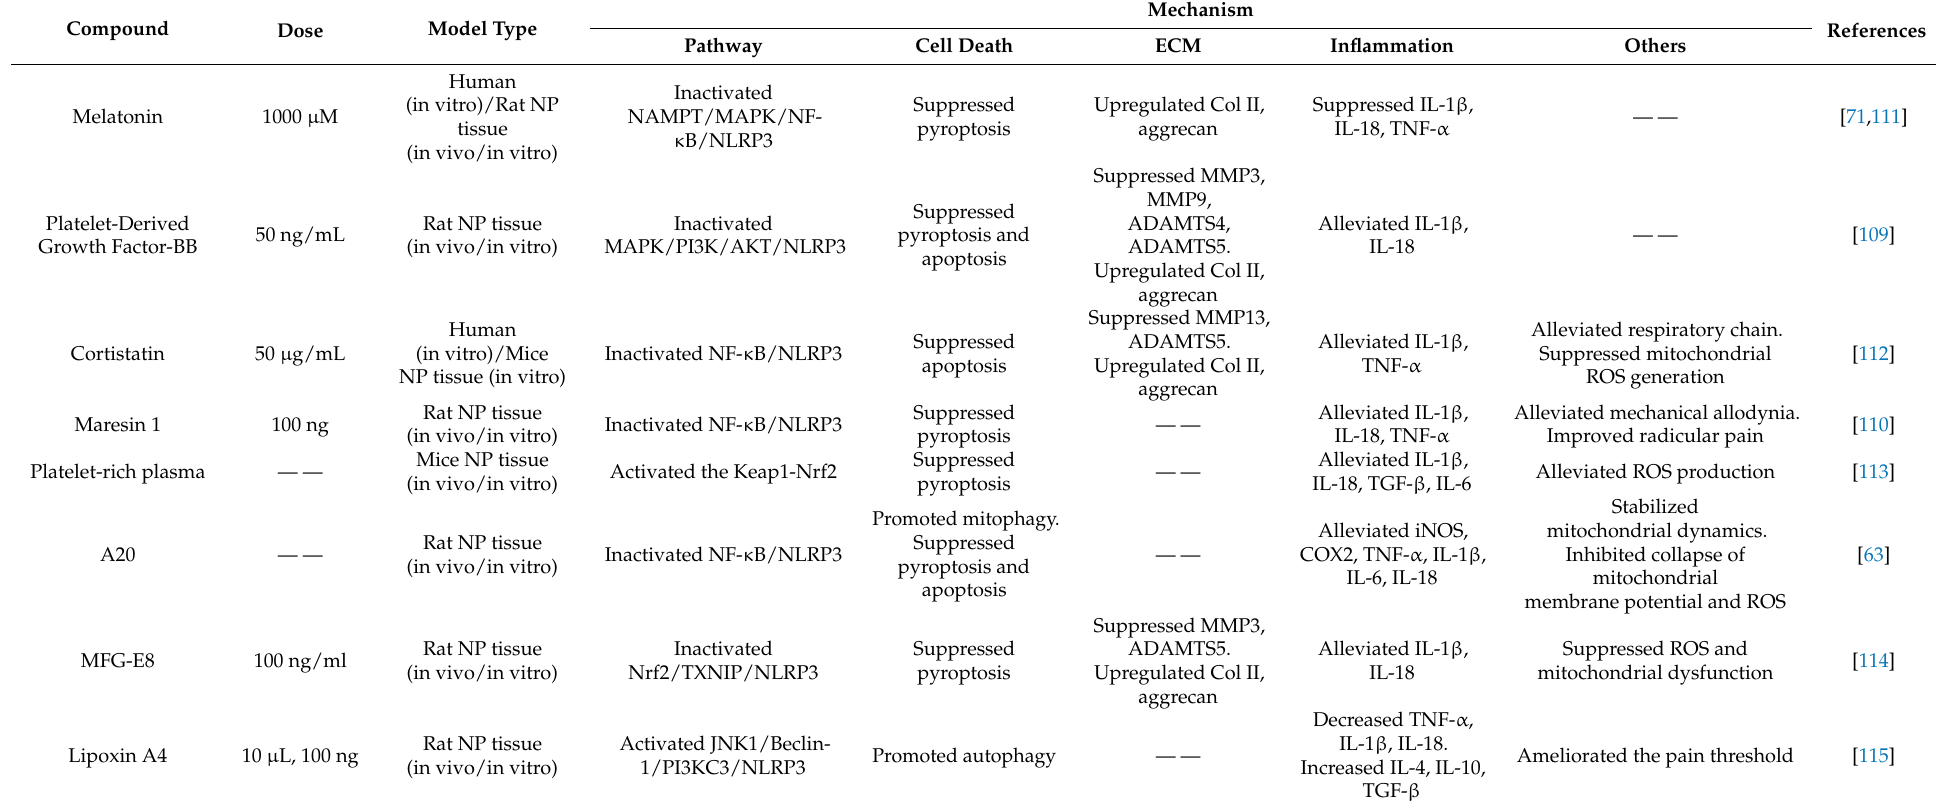
Table 2. Mechanisms of endogenous molecules for IDD treatment by inactivating